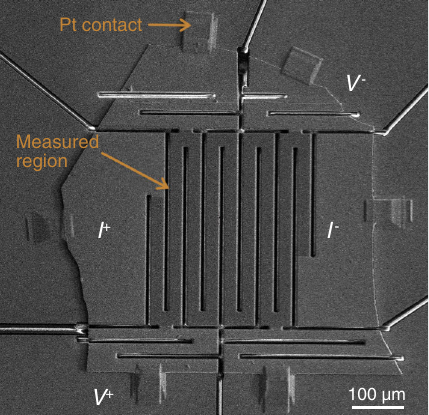
FIG. 5. SEM image of a microstructured PtCoO 2 sample used for the in situ measurements of resistivity. The measured region of the device appears darker in the SEM image because the gold has been removed from it; the rest of the sample, the Pt contacts, and the substrate are covered with sputtered